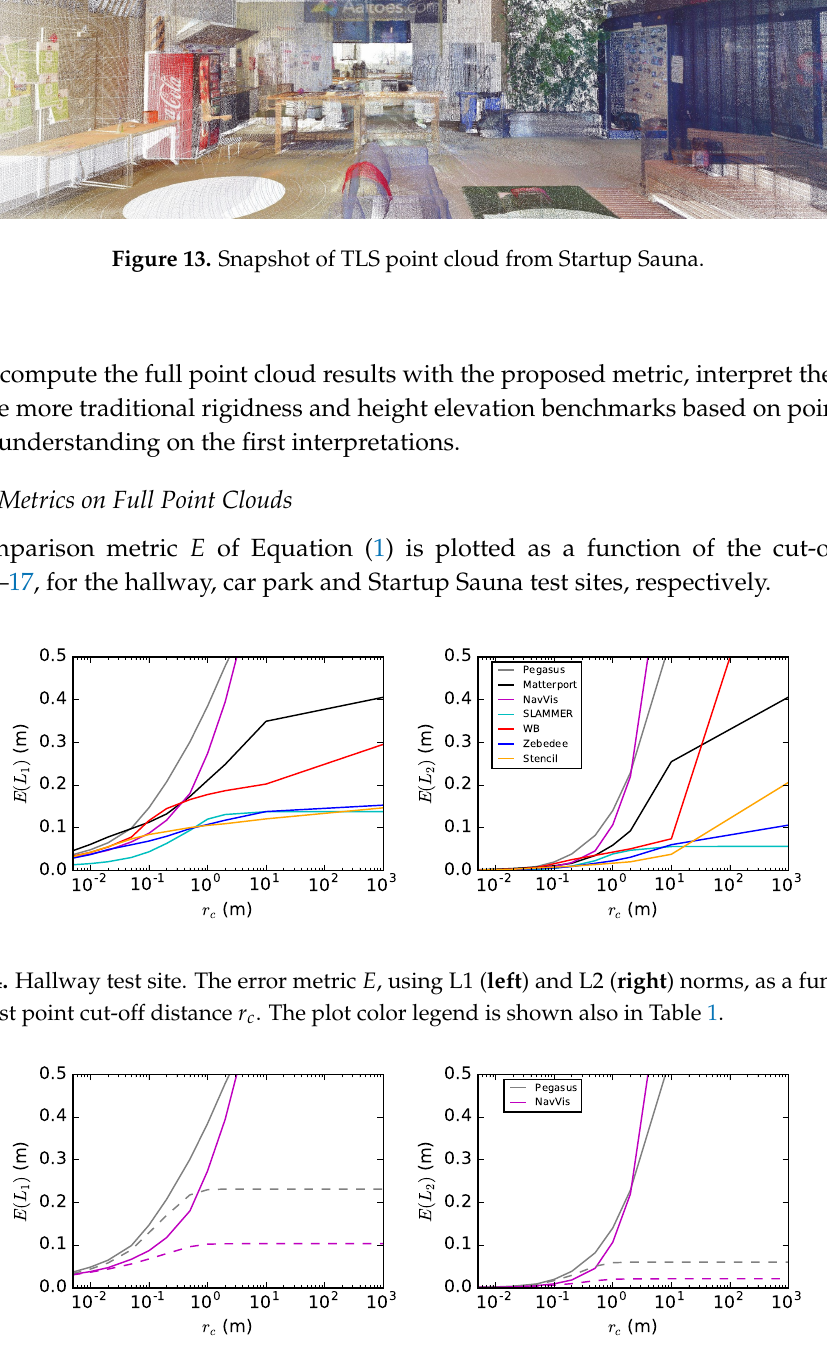
Figure 15. Hallway test site. The full point cloud results (solid lines) compared against those reduced by a manual removal of extra points (dashed lines). The error metric E , using L1 ( left ) and L2 ( right ) norms, as a function of the nearest point cut-off distance r c . Differences are visible at length scales r c > 0.1